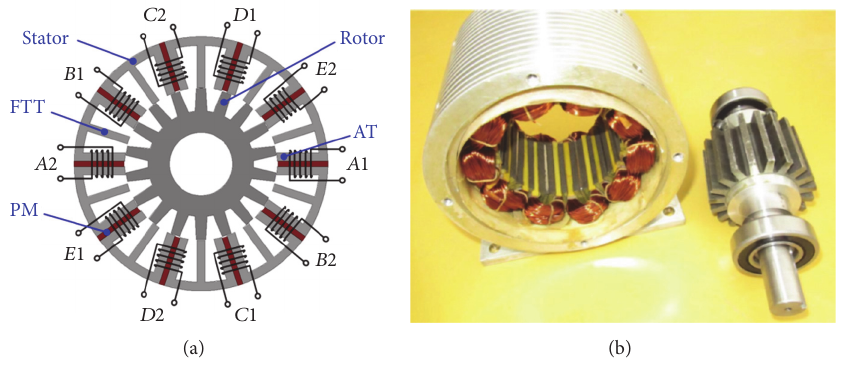
Figure 1: Five-phase FT-FSPM motor. (a) Cross section. (b) Prototype.